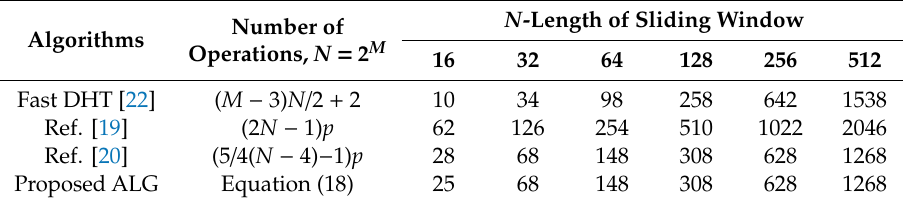
Table 2. Comparison of the tested algorithms with respect to multiplications for computing sliding DHT with p = 2.